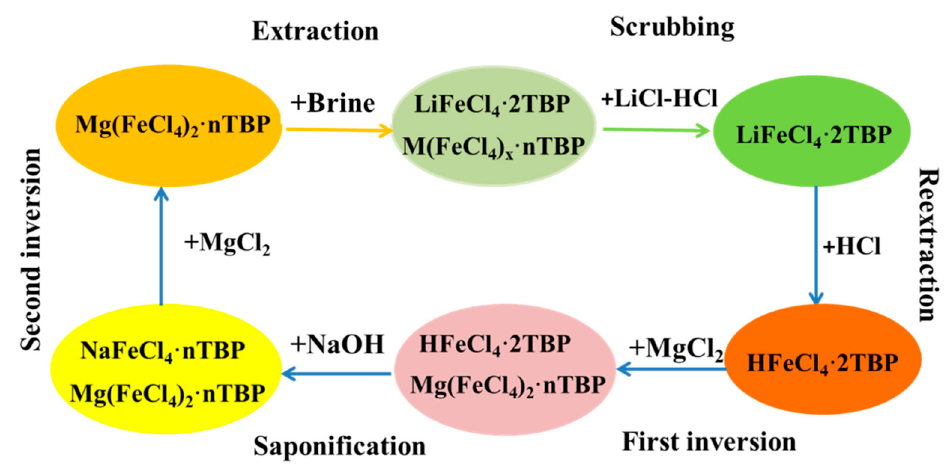
Figure 11. The conversion relationship of positive ions in organic phase.